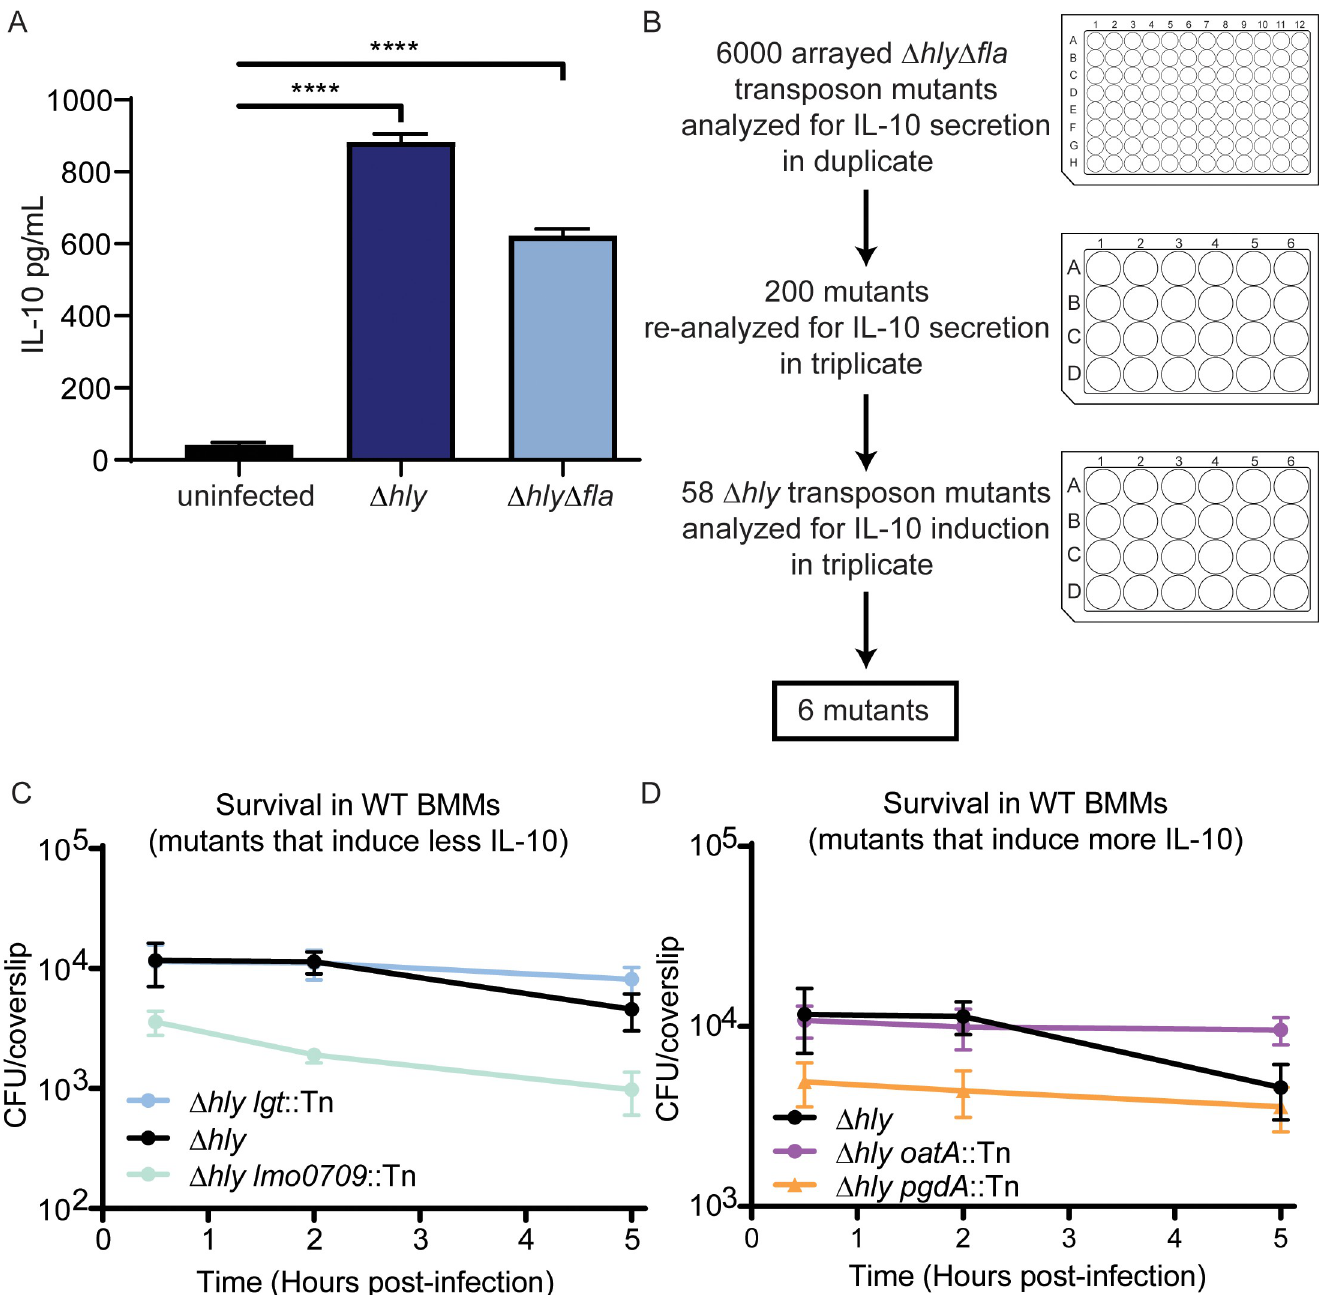
Fig 1. Vacuole-confined L . monocytogenes induce IL-10 secretion from BMMs. (A) BMMs were infected with L . monocytogenes lacking LLO ( Δ hly ) or lacking LLO and flagellin ( Δ hly Δ fla ) for four hours. Cell supernatant was collected and IL-10 was measured by ELISA. Data shown are representative of two independent experiments. Mean and SD are shown. n = 3. Data analyzed using Holm-Sidak’s multiple comparisons test. (B) Schematic of screen. 6000 Δ hly Δ fla transposon mutants were analyzed for enhanced or diminished IL-10 expression in duplicate in a 96-well plate format. 200 mutants were selected for secondary screening, and were analyzed for IL-10 in triplicate in a 24-well plate format. The mutations from 58 mutants that induced significantly enhanced or diminished IL-10 were transduced into a Δ hly background and analyzed for IL-10 secretion. Six mutations that resulted in enhanced or diminished IL-10 secretion were identified. (C and D) Survival of transposon mutants was quantified in BMMs. Mean and SEM are shown. Data are pooled from three coverslips per experiment for three independent experiments.